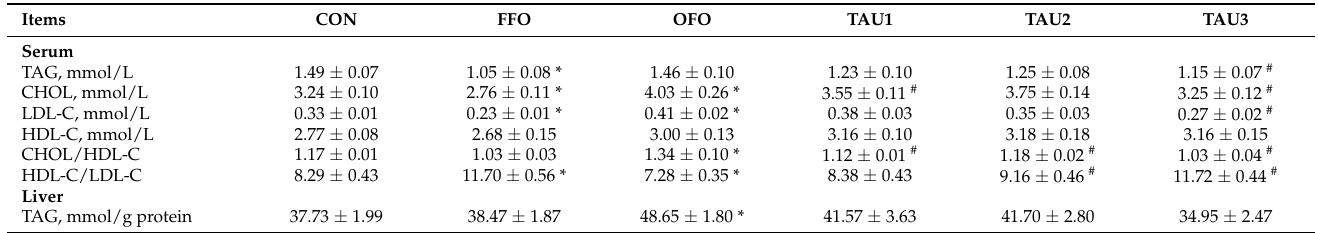
Table 3. Lipid parameters in all experimental groups of mice 1 .